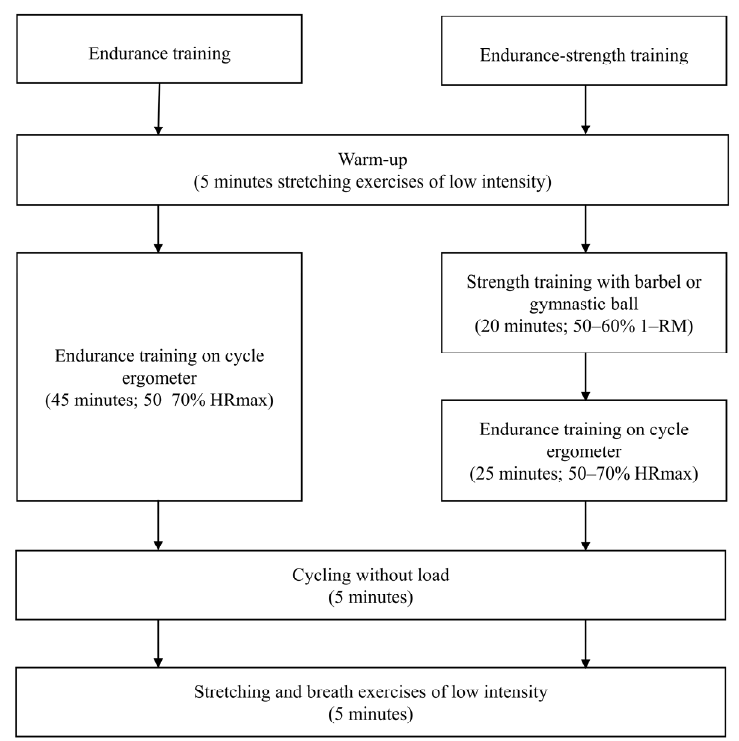
Figure 2. Scheme of a training session.